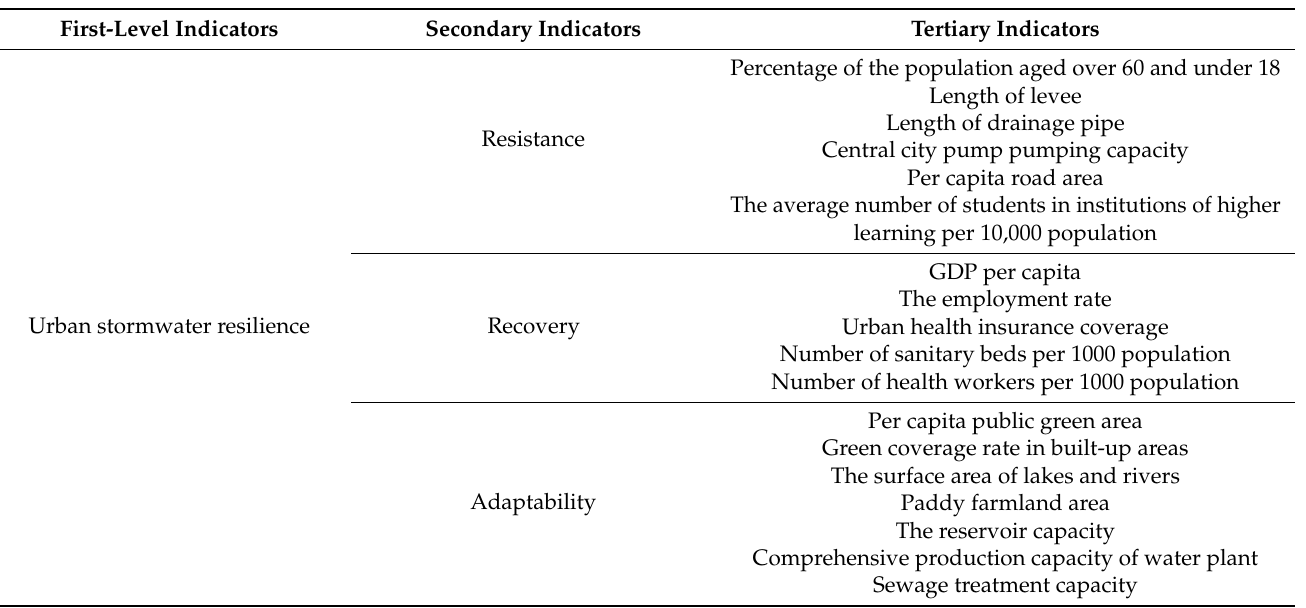
Table 1. Urban stormwater resilience evaluation index